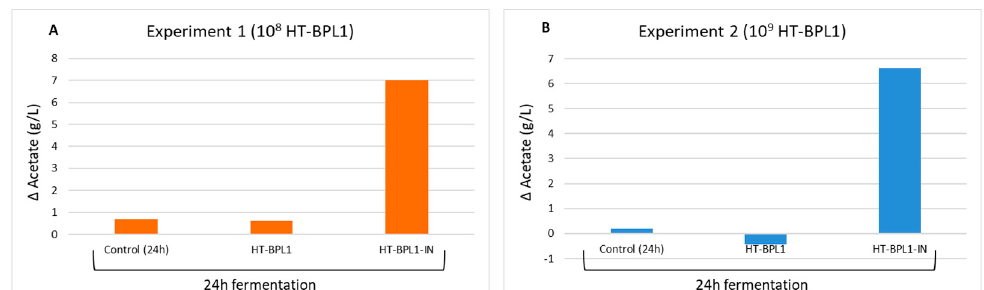
Data are means ± SD of 2 experiments in triplicate; *** p < 0.001; ** p < 0.01; * p < 0.05, with respect control. 1 LOQ (Limit of Quantification) 0.05 g/L.